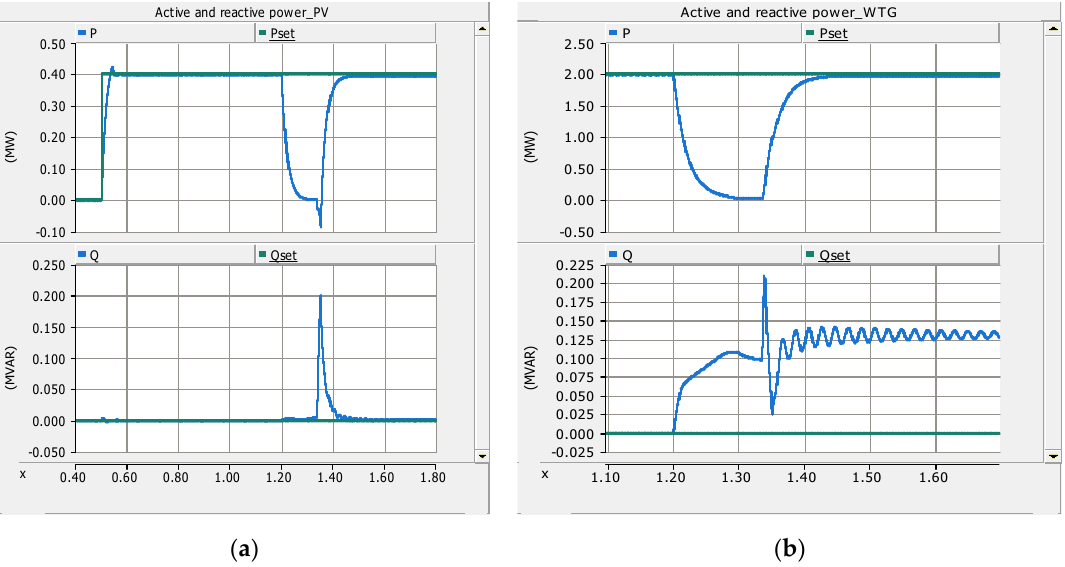
Figure 15. T Active power (P) and reactive power (Q) supply from DGs before, during and after fault F1: ( a ) P and Q from the PV system and ( b ) P and Q from the WTG. Note: WTG supplies the entire Q demand in islanded mode.